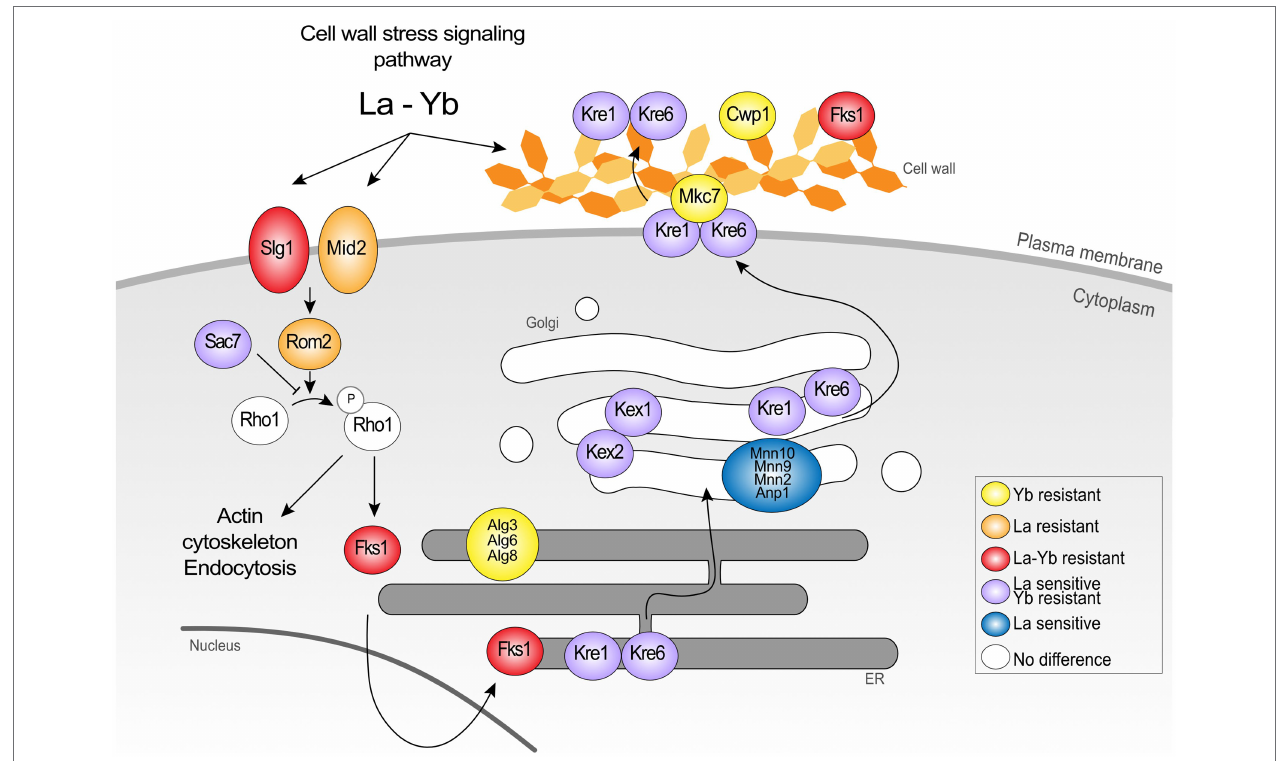
FIGURE 4 | Schematic representation of the proteins belonging to the cell wall signaling pathway and cell wall organization in the response to Ln. The data show the dual involvement of the cell wall and signalization in the response to